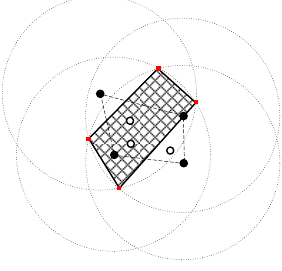
Figure 4. An example for finding a feasible region of B